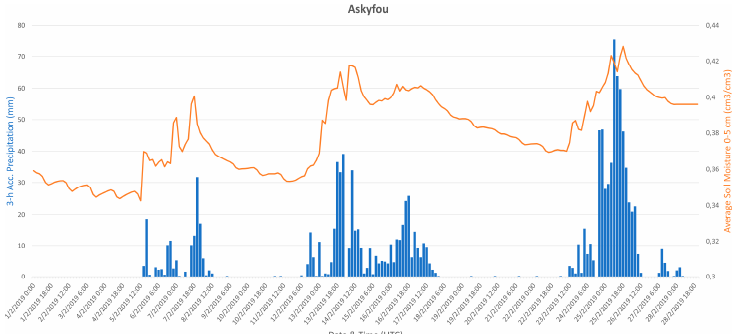
Figure 15. Time evolution of surface soil moisture volumetric content (cm 3 cm -3 ) (bold line, averaged over northwestern Crete, at 3-h intervals) and of 3-h accumulated rainfall (bar) at Askyfou during February 2019.